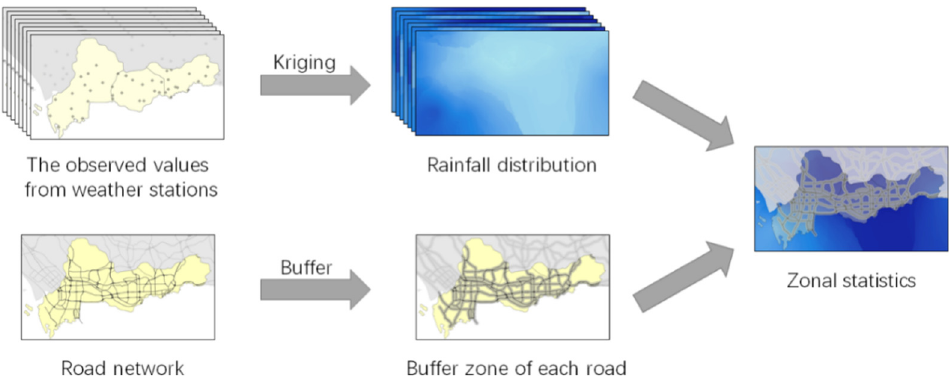
Figure 2. The schematic diagram of obtaining the rainfall intensity of each road.